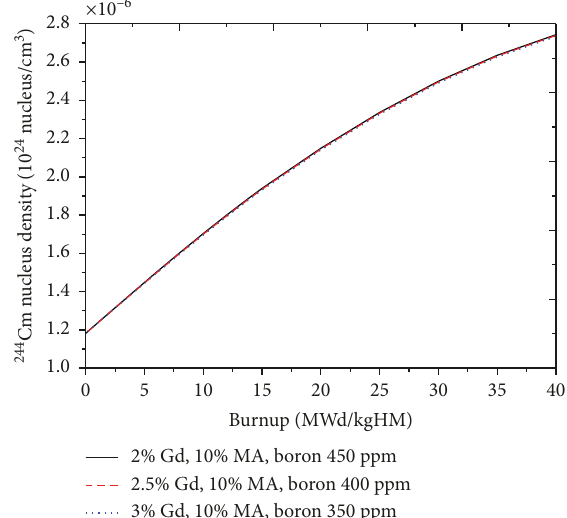
Figure 16: Transmutation of 244 Cm versus burnup when loading 10wt.% of MAs.